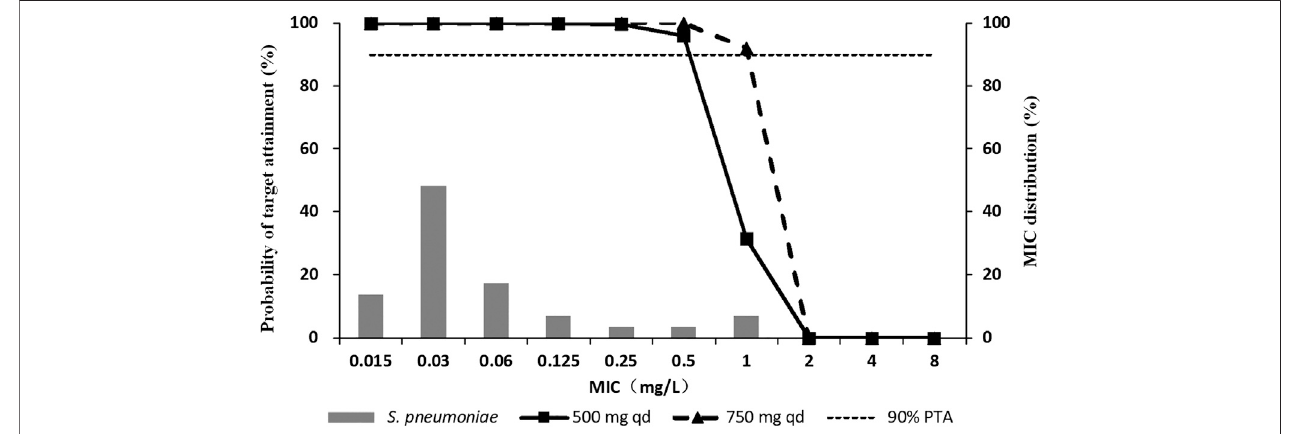
FIGURE 5 | Probability of target attainment (PTA) of nemonoxacin in terms of f AUC 0-24 /MIC ≥ 44.4 (2-log 10 CFU kill) following oral administration of nemonoxacin malate sodium chloride in healthy Chinese subjects, overlaid on the MIC distribution for S. pneumoniae .